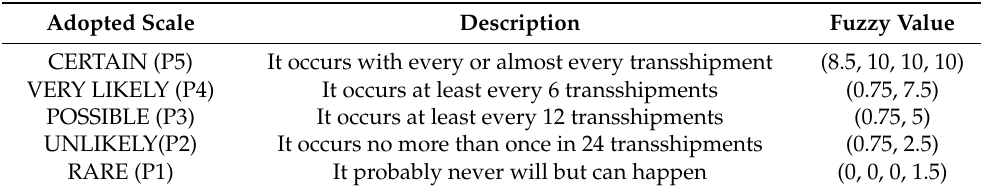
Table 4. Probability of scenario